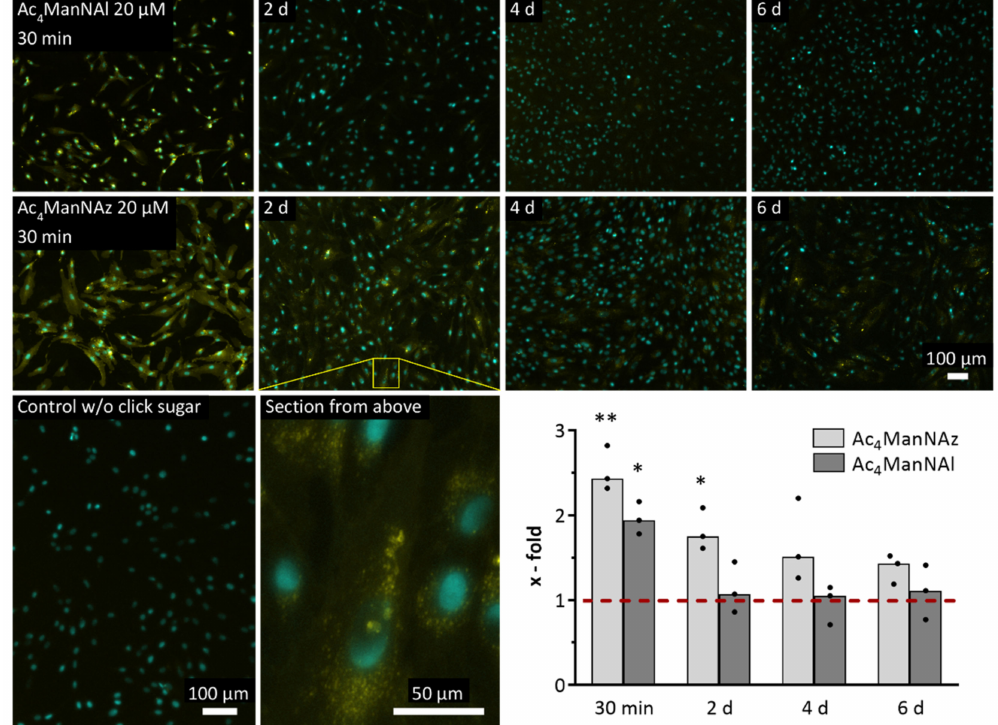
Figure 3. Temporal course of the decline of glycocalyx modification in hMSC-TERT after 72 h incubation with Ac 4 ManNAz or Ac 4 ManNAl. Yellow: fluorescence signal of Cy 3/5 after CuAAC click reaction, cyan: fluorescence signal of cell nuclei. Representative fluorescence images of three independent experiments are shown. The diagram shows the quantitative analysis of fluorescence micrographs from three independent experiments. Cy 3/5 fluorescence signal as a mean grey value is depicted relative to the DMSO-treated control (dashed line). Datasets (median with individual values) were tested for significance using two-tailed paired t -test ( p < 0.05 depicted as *, p < 0.01 depicted as